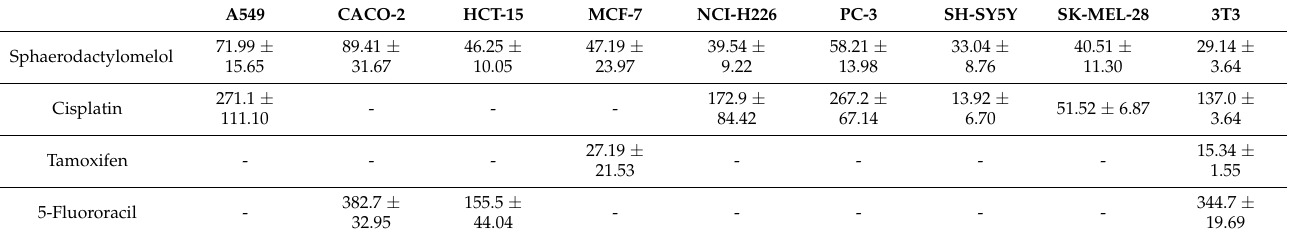
Table 1. Values of IC 50 ( µ M) determined for sphaerodactylomelol (0.1–100 µ M) and standard drugs (0.1–500 µ M) on tumorigenic cell lines and fibroblasts following 24 h treatment. The values represent the mean plus standard deviation. At least three independent experiments in triplicate were carried out.